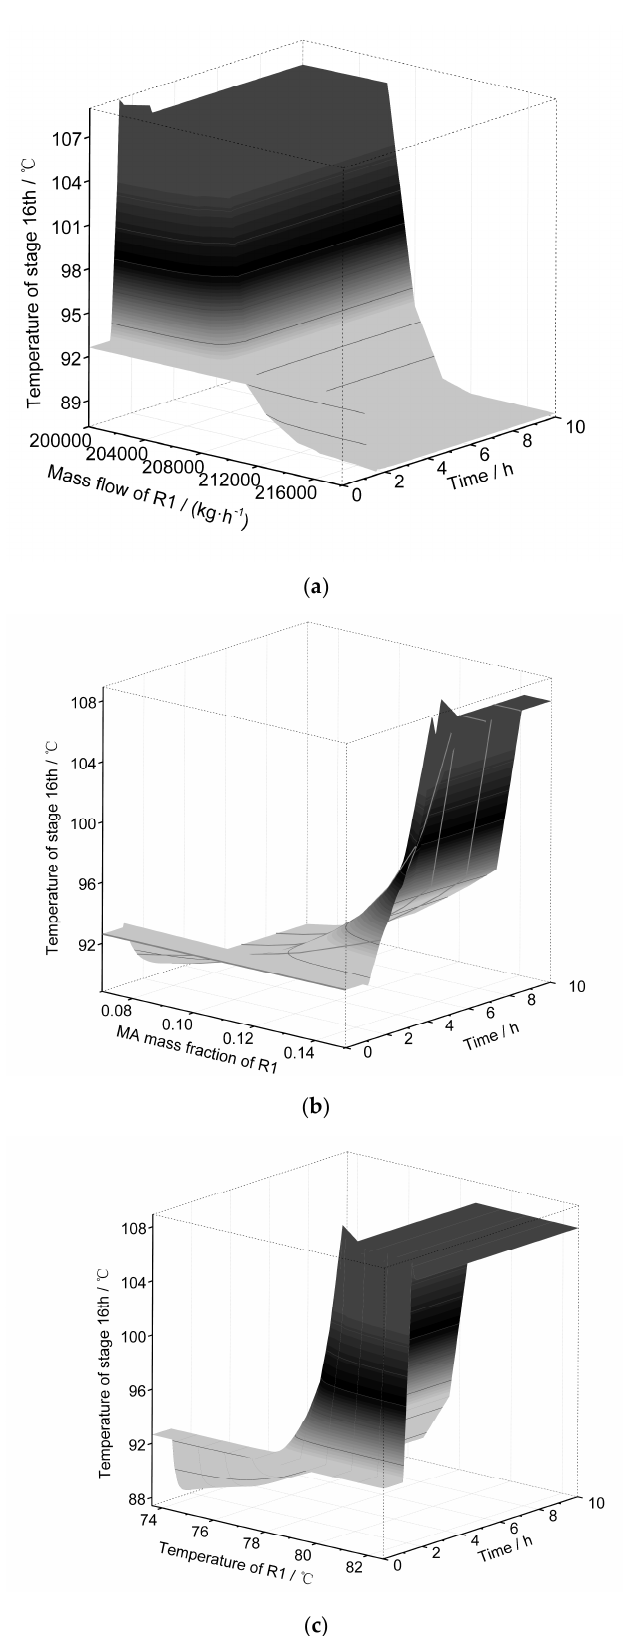
Figure 5. Dynamic sensitivity analysis of the R1 strand on the temperature of sensitive plate. ( a ) Dynamic sensitivity analysis of the R1 mass flow. ( b ) Sensitivity analysis of the MA mass fraction in R1. ( c ) Sensitivity analysis of the R1 temperature.